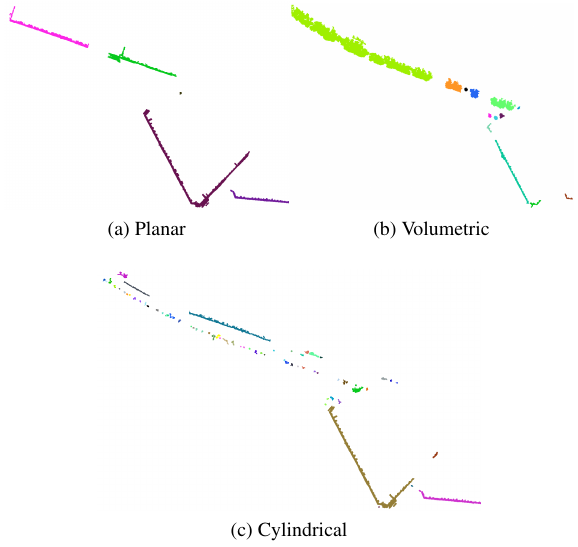
Figure 9: Accumulation maps descriptors after different filters.